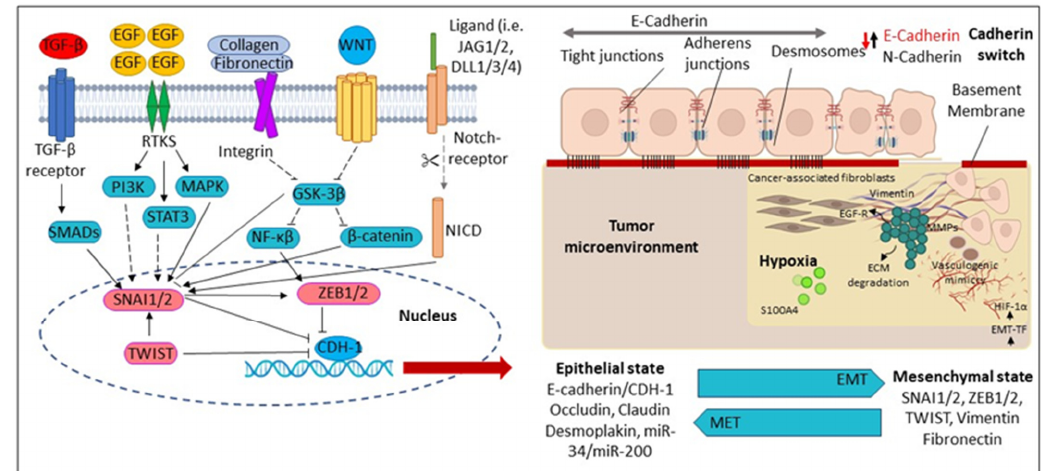
Figure 3. Molecular mechanisms regulating Epithelial-Mesenchymal Transition (EMT). During EMT, the epithelial cells are converted into mesenchymal-like cells. The reverse transition from mesenchymal to epithelial cells is known as a mesenchymal–epithelial transition (MET). CDH1 (Cadherin 1); DLL1/3/4 (Delta-like canonical Notch ligand 1); ECM (Extracellular matrix); EGF (Ep- idermal growth factor); EGFR (Epidermal growth factor receptor); EMT-TF (Epithelial-mesenchy- mal transition-transcription factors); GSK3 β (Glycogen synthase kinase-3 beta); HIF-1 α (Hypoxia- inducible factor-1); JAG2 (Hs00171432_m1), JAG1 (Hs01070032_m1); MAPK (Mitogen-activated pro- tein kinase); MMPs (Matrix metalloproteinases); NICD (Notch Intracellular Domain); PI3K (Phos- phatidylinositol 3 kinase); SMAD (Suppressor of Mothers against Decapentaplegic); SNAI1 (Zinc finger protein); STAT3 (Signal transducer and activator of transcription 3); TGF- β (Transforming growth factor- β ); TWIST1 (Twist-related protein-1); WNT (Wingless/Integrated pathway); ZEB1/2 Zinc finger and homeodomain transcription factor.